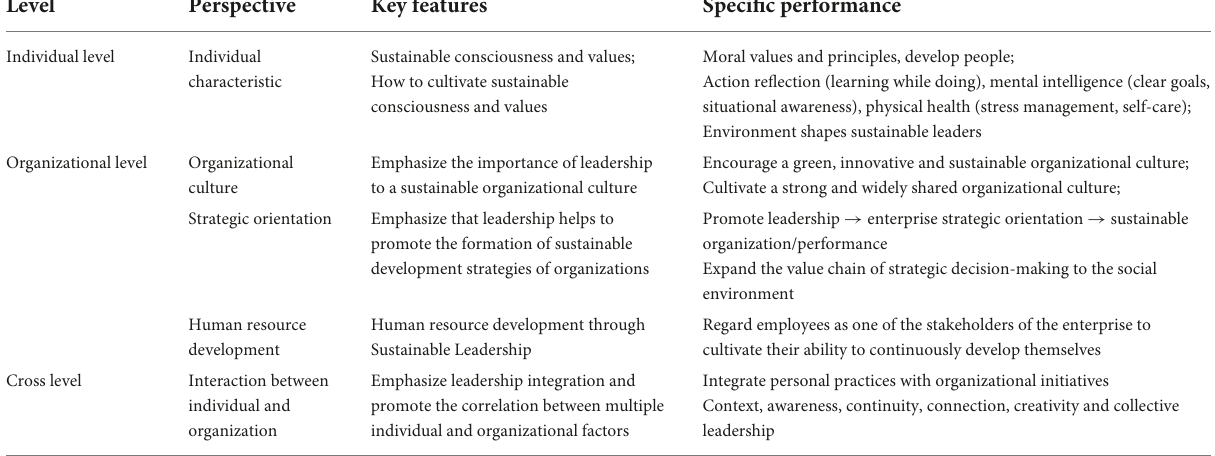
TABLE 1 The connotation and analytical perspective of sustainable